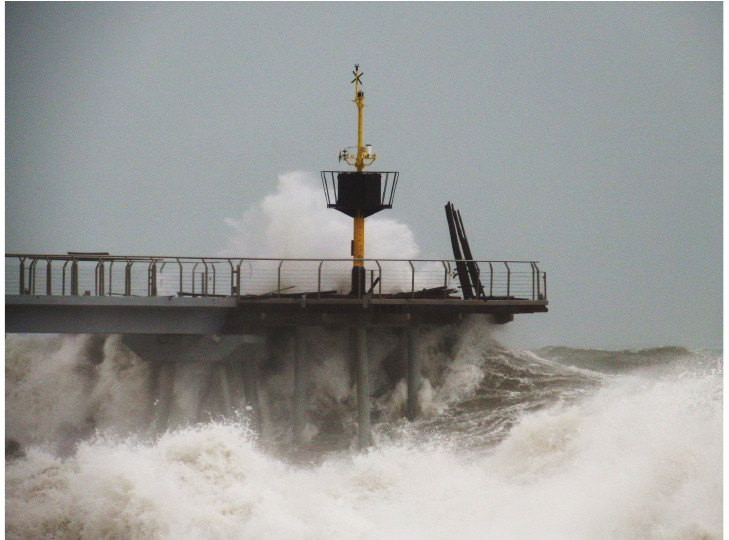
Figure 5. A large wave hitting the platform of the Pont del Petroli during storm Gloria. (Source: Badalona City